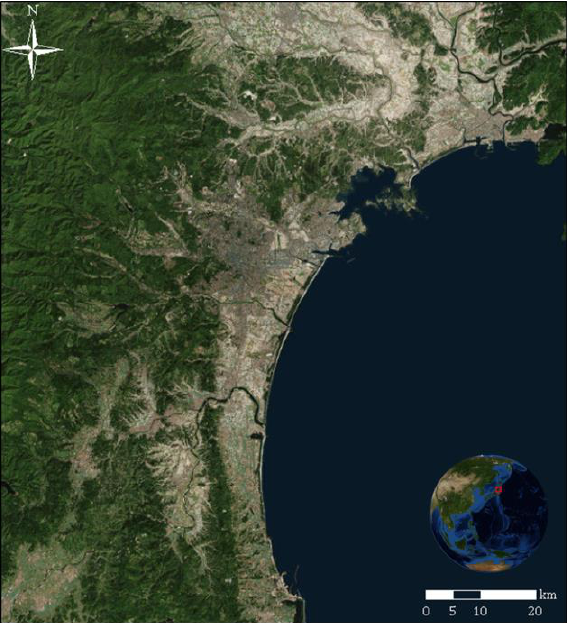
Figure 1. Japan north-eastern coastline.